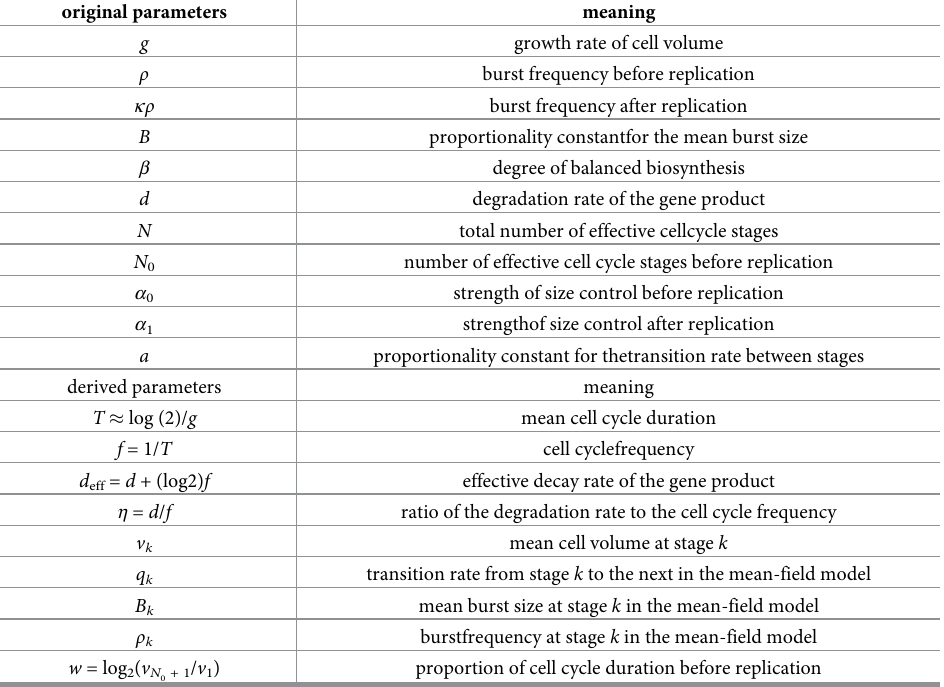
Table 1. Model parameters and their